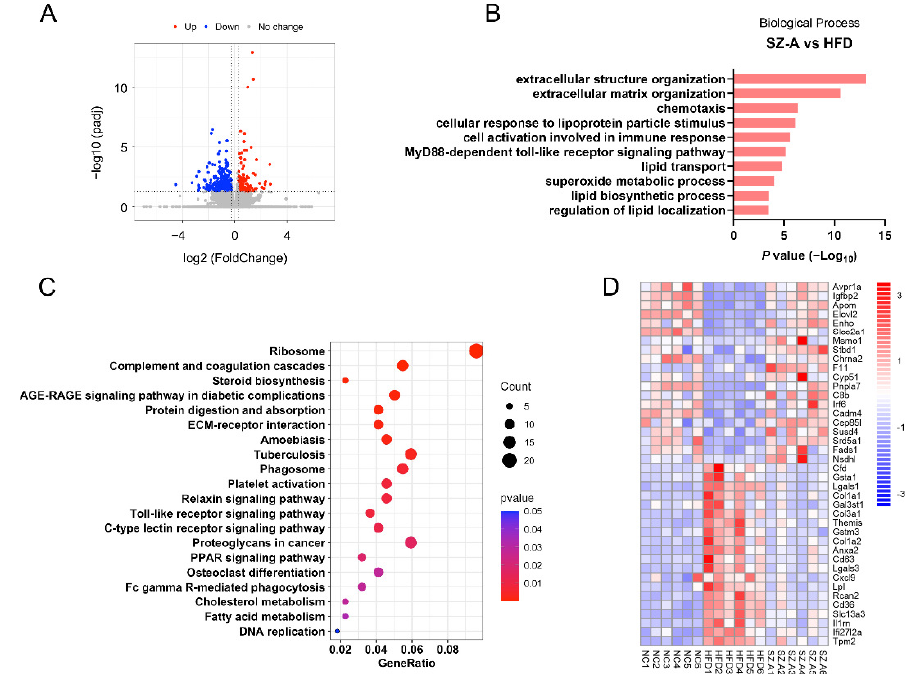
Figure 5. Gene expression signatures of SZ-A-treated mice. ( A ) Volcano plot of the differentially expressed genes (Padj < 0.05, fold change > 1.2) in livers of HFD control and SZ-A group ( n = 6 per group). Red and blue represent high and low expression of genes in the SZ-A group, respectively. ( B ) GO analysis of biological processes related to NAFLD of differentially expressed genes. ( C ) The 20 highest-ranking terms from KEGG analysis of all differentially expressed genes (Padj < 0.05, fold change > 1.2) are shown. ( D ) Heatmap of the top 20 upregulated and downregulated genes is shown (Padj < 0.05). NC, normal control; HFD, high-fat diet; SZ-A, Ramulus Mori (Sangzhi) alkaloids.